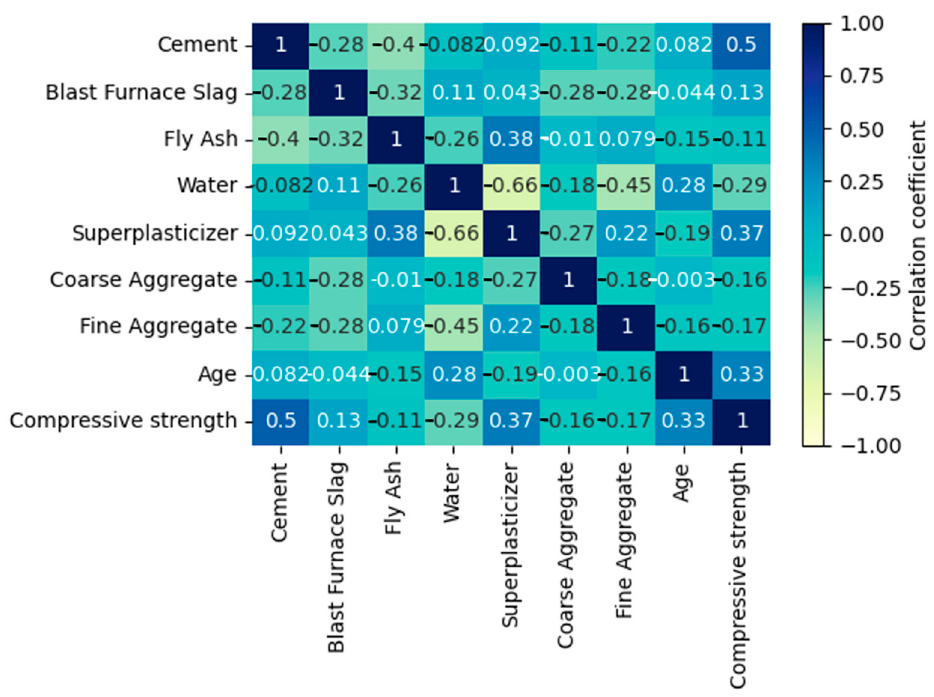
Figure 1. Correlation coefficient matrix of each variable in the CC dataset.